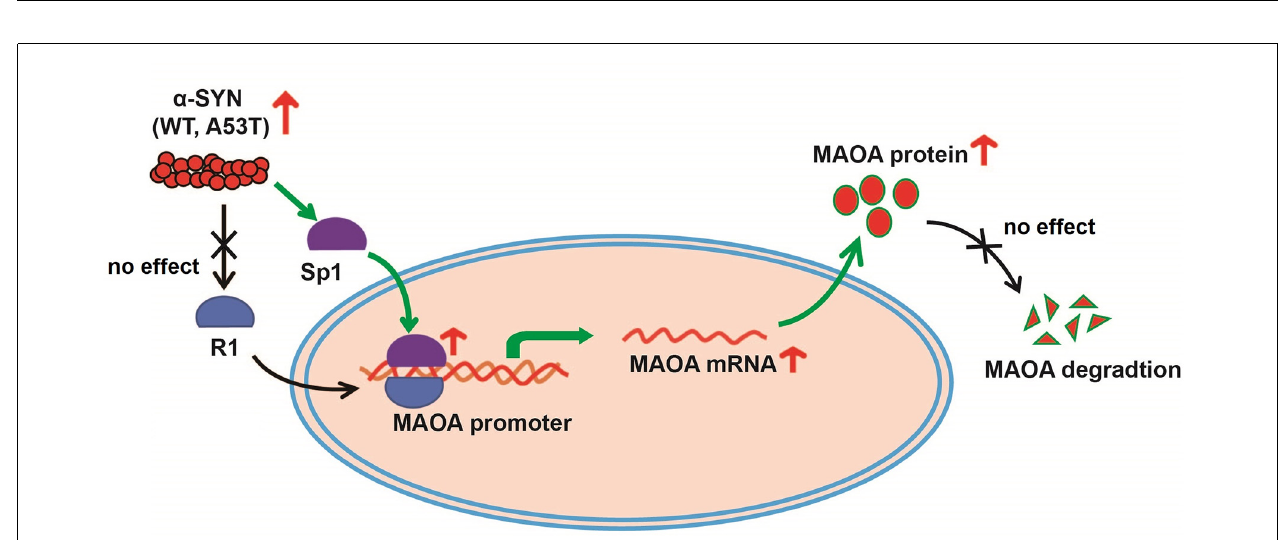
FIGURE 6 | The schematic illustration of mechanisms underlying α -SYN-induced MAOA increase. Overexpression of α -SYN WT and α -SYN A53T selectively up-regulated Sp1 expression and the binding quantity of Sp1 with MAOA promoter, thereby increasing MAOA expression and activity.